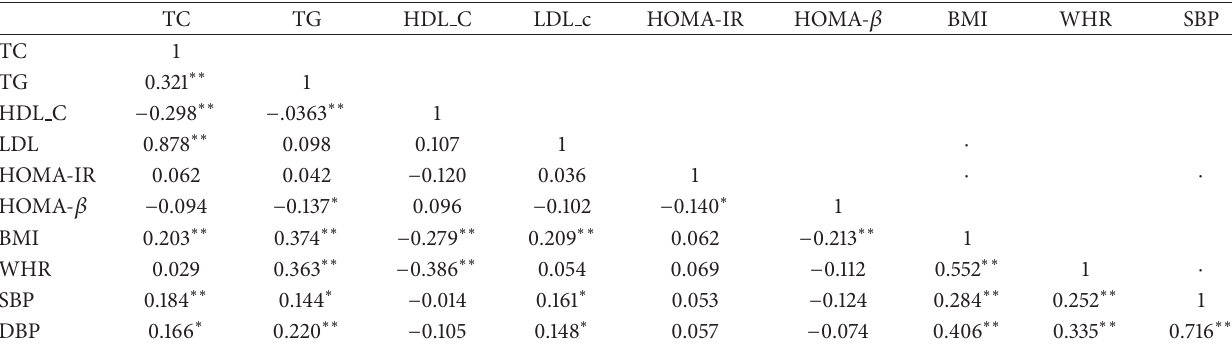
Table 2: Spearman correlation coefficients between cardiovascular factors in normal glucose